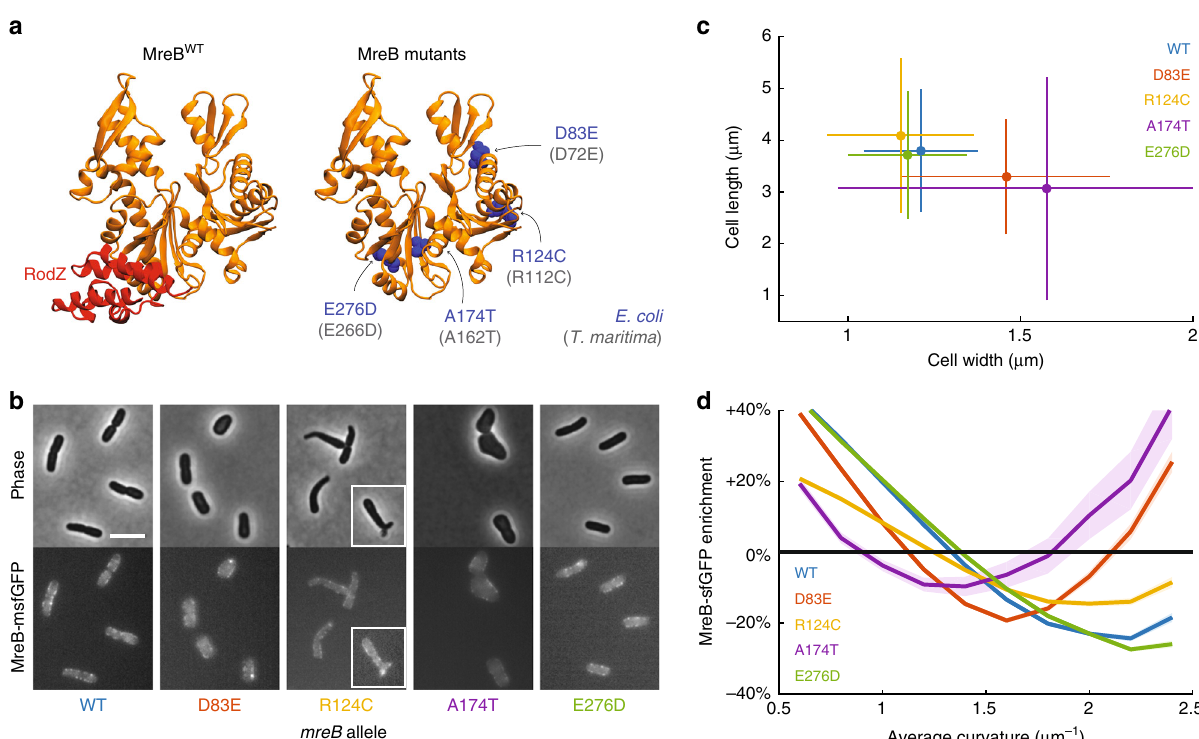
Fig. 3 Genetic perturbations that alter the MreB curvature enrichment pro fi le. a RodZ binds near the polymerization interface in domain IIA of MreB (left). Mutations in MreB previously identi fi ed 30 to suppress Δ rodZ growth defects (D83E, R124C, and A174T), as well as a mutation at the polymerization interface (E276D), are spread throughout the protein and are conserved in T . maritima MreB (gray text in parentheses; right). b MreB mutants (all as sandwich fusions to msfGFP) have a variety of cell shapes, including wider cells (MreB D83E ), tapered and sometimes branched cells (MreB R124C ; white box highlights a branched cell), much wider and rounder cells (MreB A174T ), and wild-type-like cells (MreB E276D ). Scale bar is 5 µ m. c , d Strains that harbor mutations in MreB that suppress Δ rodZ growth defects have altered cellular dimensions ( c ) and MreB curvature enrichment pro fi les ( d ) relative to wild type, whereas MreB E276D cells are similar to wild type. Error bars in c represent standard deviation of populations with n > 230 cells. All bins in d include at least 50 observations, and shaded areas represent standard deviation of enrichment from resampled data for each